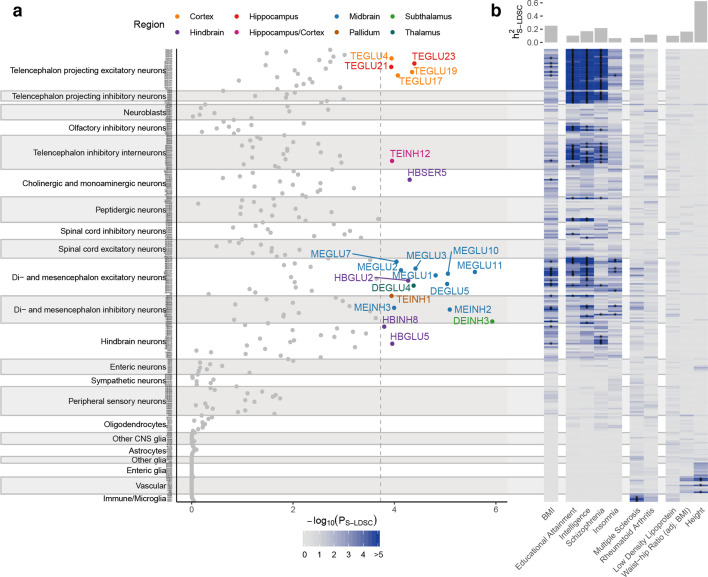
Cell type prioritization of mouse nervous system cell types highlights cell types outside canonical energy homeostasis circuits.(a) Prioritization of 265 mouse nervous system cell types identified 22 cell types from eight distinct brain regions as significantly associated with BMI. The highlighted cell types passed the Bonferroni significance threshold, PS-LDSC <0.05/265. Cell types are grouped by the taxonomy described in Zeisel et al., 2018. (b) Heatmap of cell type prioritization for multiple GWAS traits. The four brain-related traits (second column) were primarily associated with cortical neurons (telencephalon projecting and interneuron cell types) and did not overlap with the BMI-associated cell types. The two immune traits (third column) were associated with microglia, and anthropometric traits (fourth column) were predominantly associated with vascular cell types. Asterisks (*) mark cell types passing the per-trait Bonferroni significance threshold. The top bar plot shows the estimated trait heritability. Metadata for the Mouse Nervous System dataset are available in Figure 3—source data 1, CELLECT results for the Mouse Nervous System dataset are available in Figure 3—source data 2, CELLEX expression specificity values for the BMI GWAS-enriched cell types are available in Figure 3—source data 3 and cognitive traits and psychiatric disorders CELLECT results limited to the 22 BMI GWAS-enriched cell types are available in Figure 3—source data 4.Figure 3—source data 1.Mouse Nervous System metadata.Figure 3—source data 2.Mouse Nervous System CELLECT results.Figure 3—source data 3.Mouse Nervous System expression specificity results.Figure 3—source data 4.Mouse Nervous System results for other traits and diseases.Figure 3—source data 5.WGCNA results overview.Figure 3—source data 6.WGCNA results for the top module M1.Figure 3—source data 7.MAGMA results.